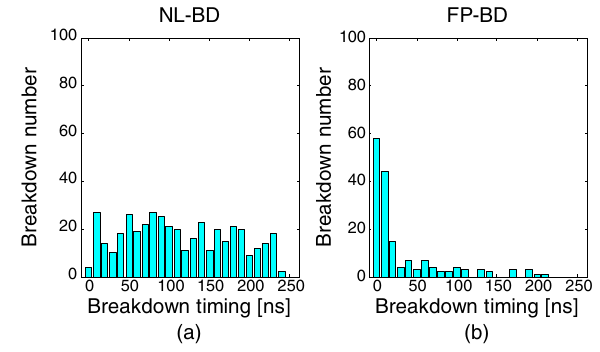
FIG. 20. Breakdown timing distribution of